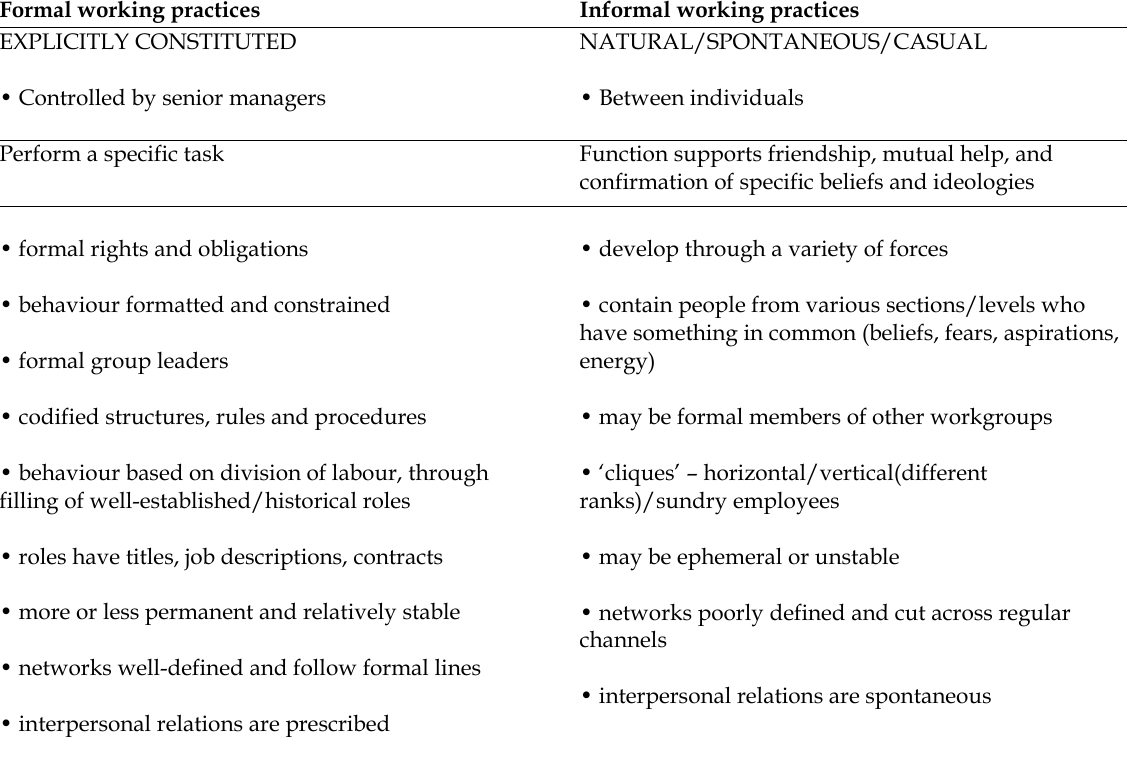
Table 2. Comparison of formal and informal working practices (after Tricker et al